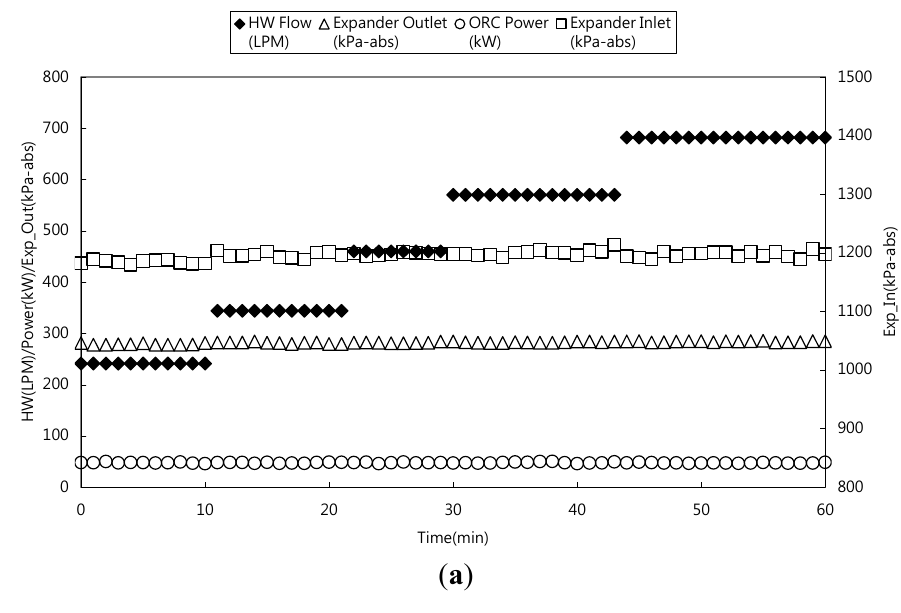
, P , HW; exp,in exp,out : evaporator e,s